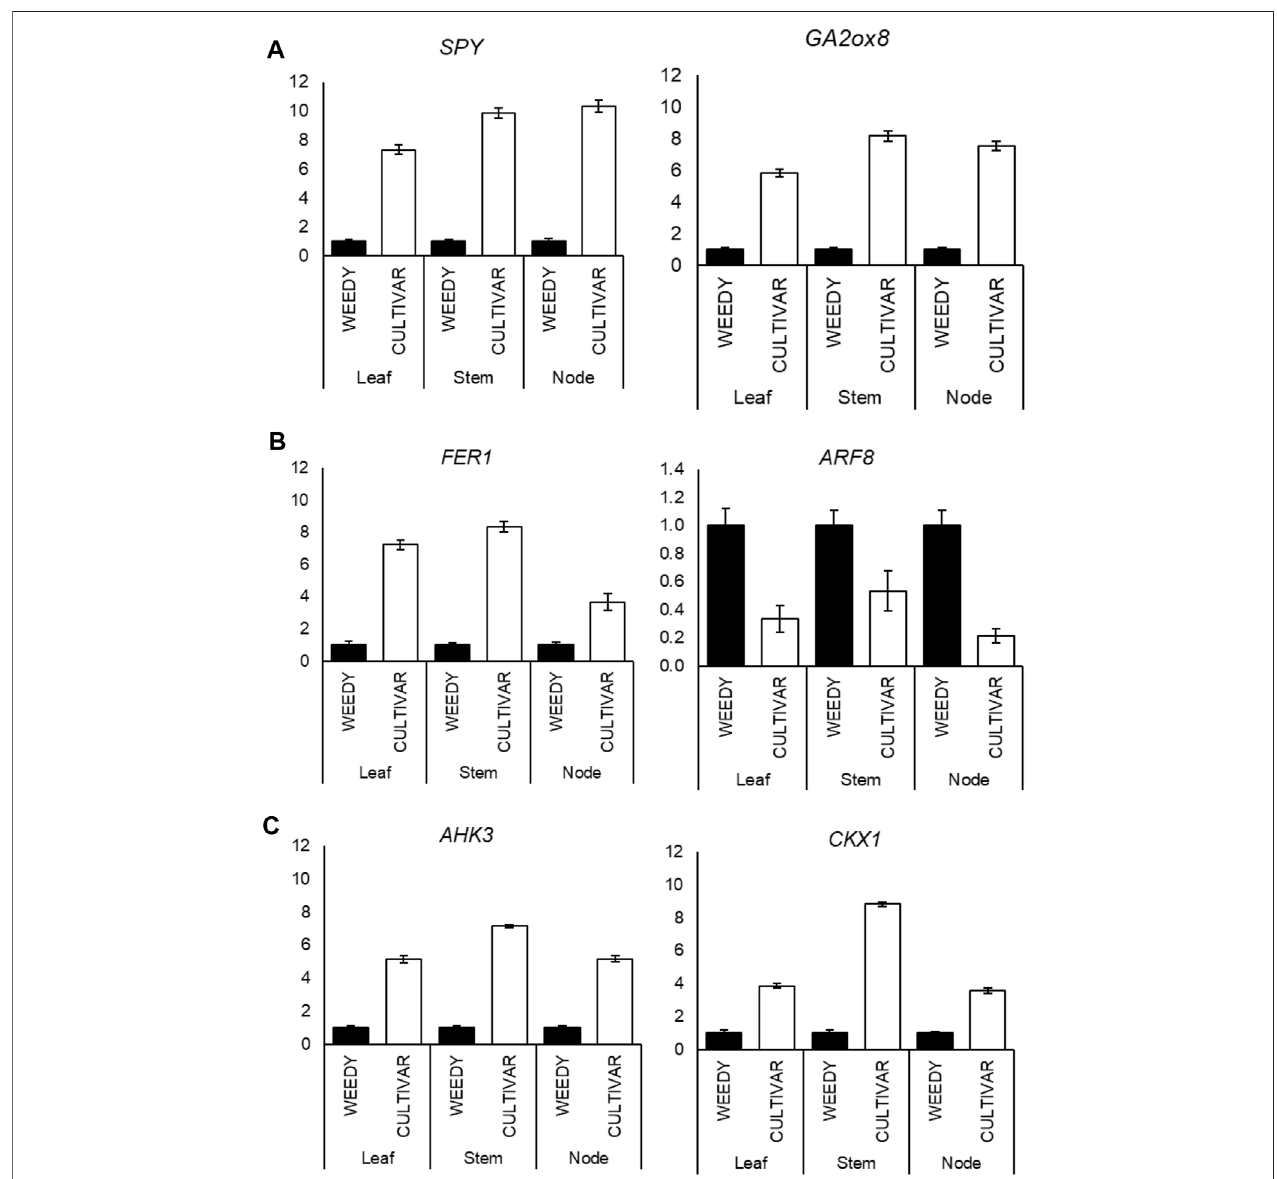
FIGURE4|(A – C) Reverse-transcriptionquantitativePCR(RT-qPCR)analysisshowschangesingibberellinresponsegenes:gibberellin2-oxidase8( GA2ox8 )and SPINDLY ( SPY ) (A) ; auxin response genes: FERONIA ( FER ) and auxin response factor ( ARF8 ) (B) ; and cytokinin response genes: Arabidopsis histidine kinase-3 ( AHK3 ) and cytokinin dehydrogenase-1 ( CKX1 ). (C) Expression levels in the leaves, stems, and nodes of weedy type (WT) and cultivar type (CT). Total RNA was prepared from the 12-week-old plants for the indicated samples. Control plants were weedy type (WT). Error bars indicate SD of triplicate measurements. GmAct6 was used as internal control, and relative expression levels are shown as fold